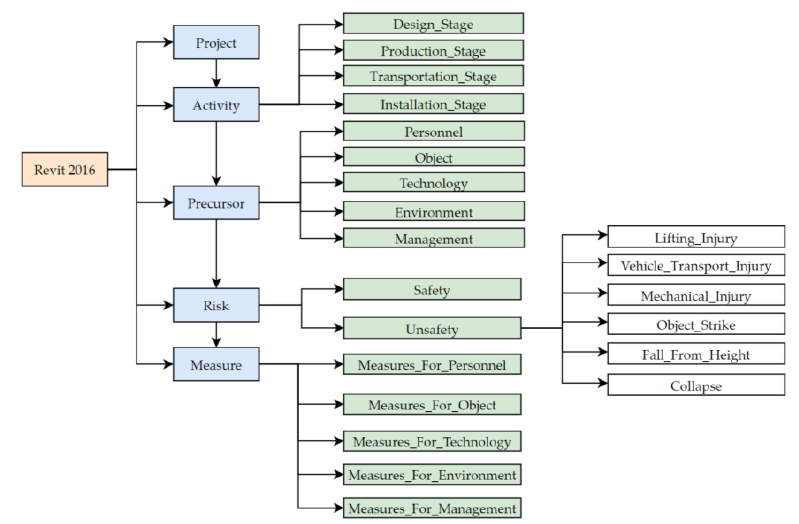
Figure 4. Ontology view of safety risk